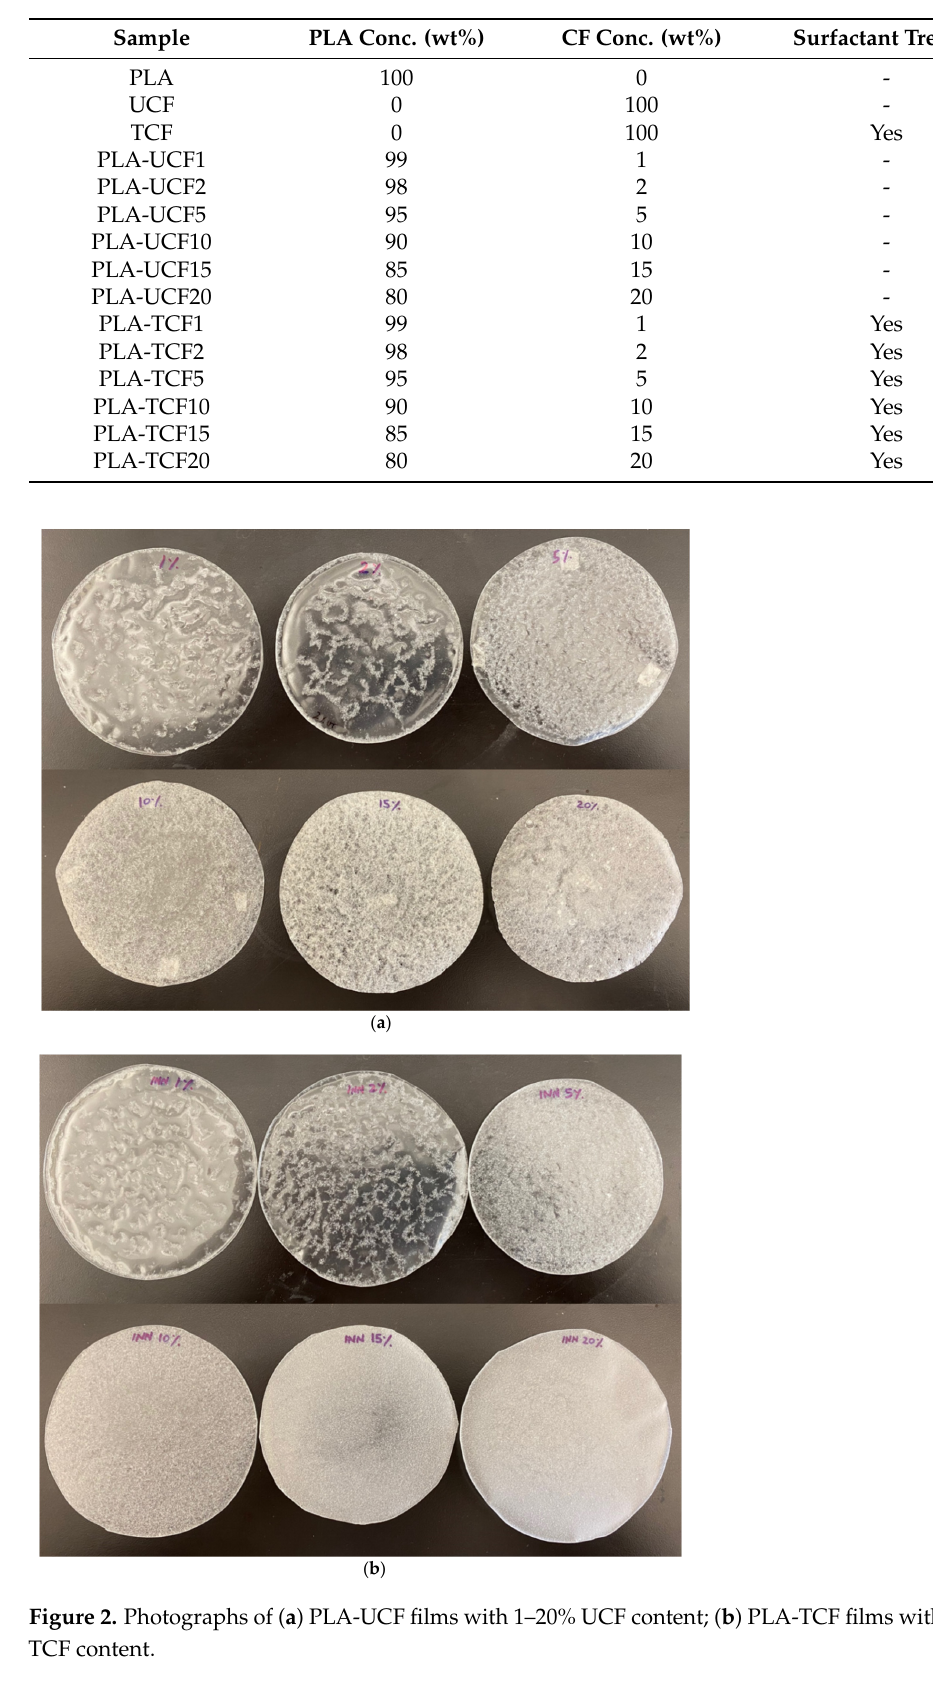
Table 1. Description of film samples prepared for this study.